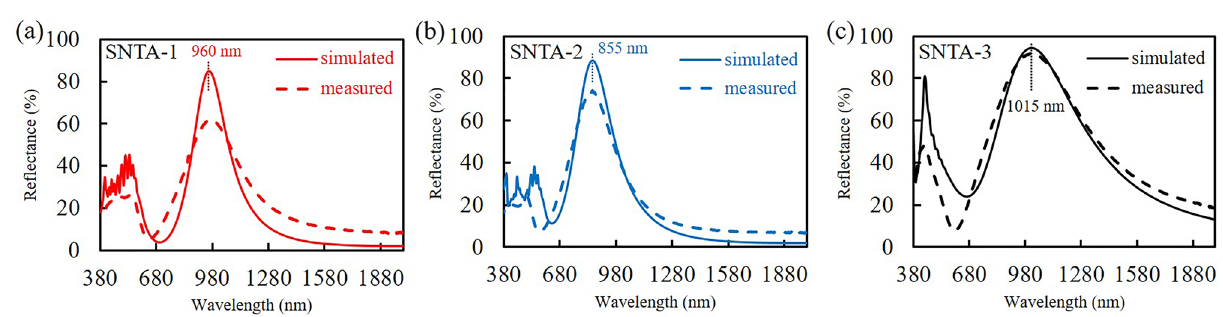
Figure 4. Simulated and measured R TM spectra of ( a ) SNTA-1, ( b ) SNTA-2, ( c ) SNTA-3.